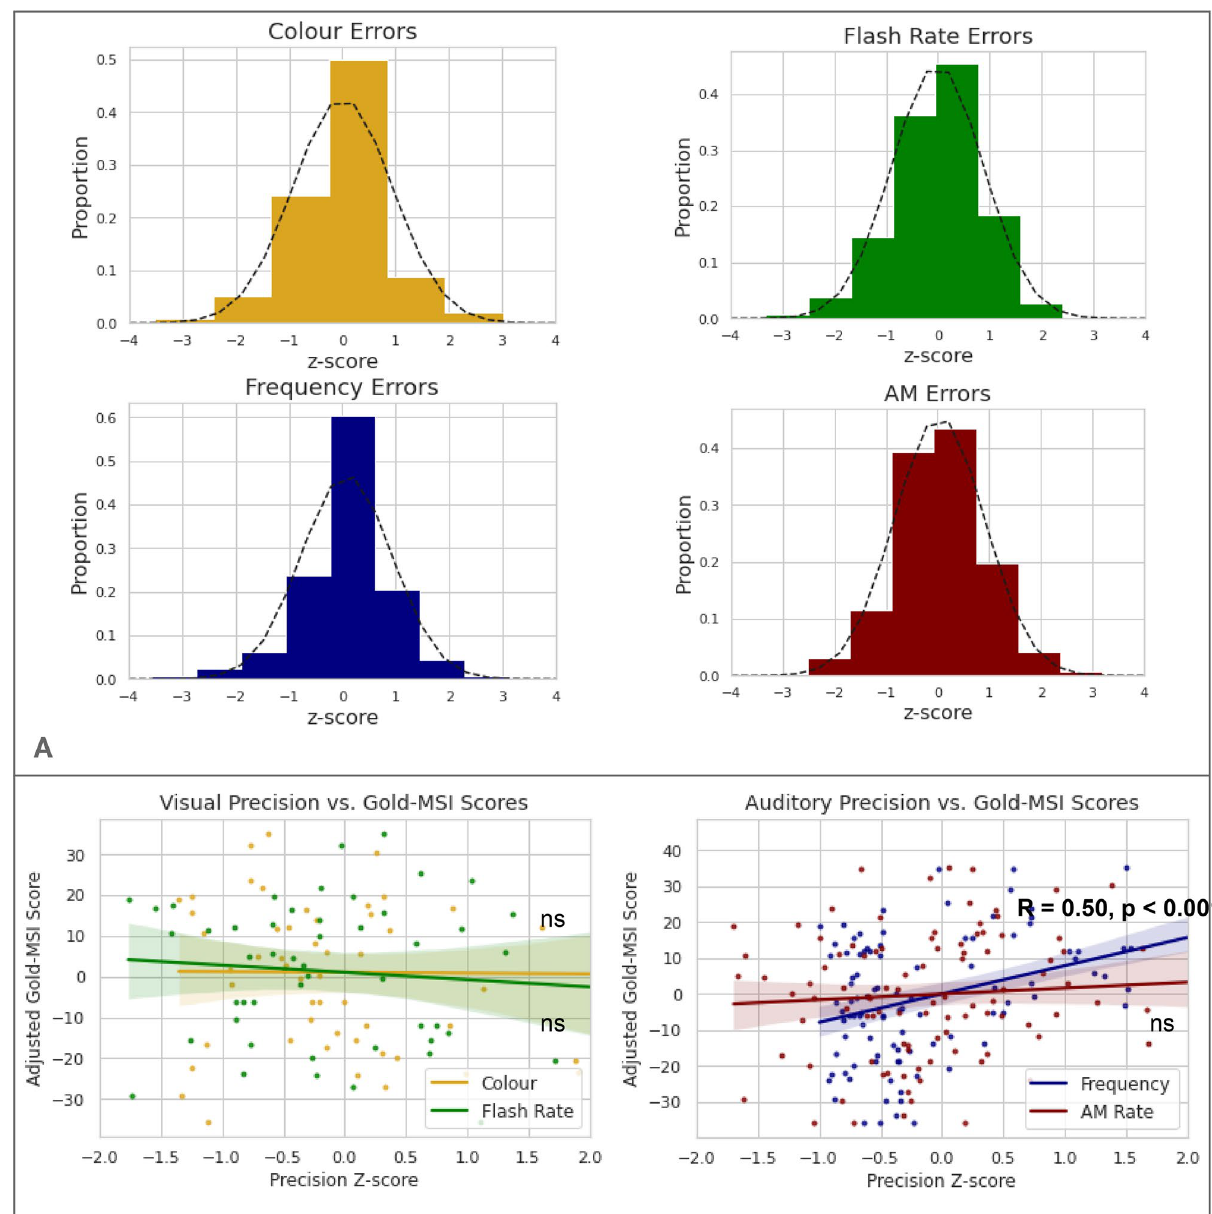
Figure 2. ( A ) The distributions for all domains of working memory tested in Experiment 1 are shown. All participants’ performances were Gaussian. Z-scores are used for errors on the x-axis for the purposes of illustration. ( B ) Scatter plots showing overall working memory precision for visual (top row) and auditory (middle row) stimuli as a function of transformed scores on the Gold-MSI questionnaire. Performance with visual stimuli was not significantly correlated with Gold-MSI scores. For auditory stimuli, working memory precision for frequency (represented by the dark blue line) was significantly correlated with Gold-MSI scores, but working memory precision for AM rate (represented by the red line) was not. ns not